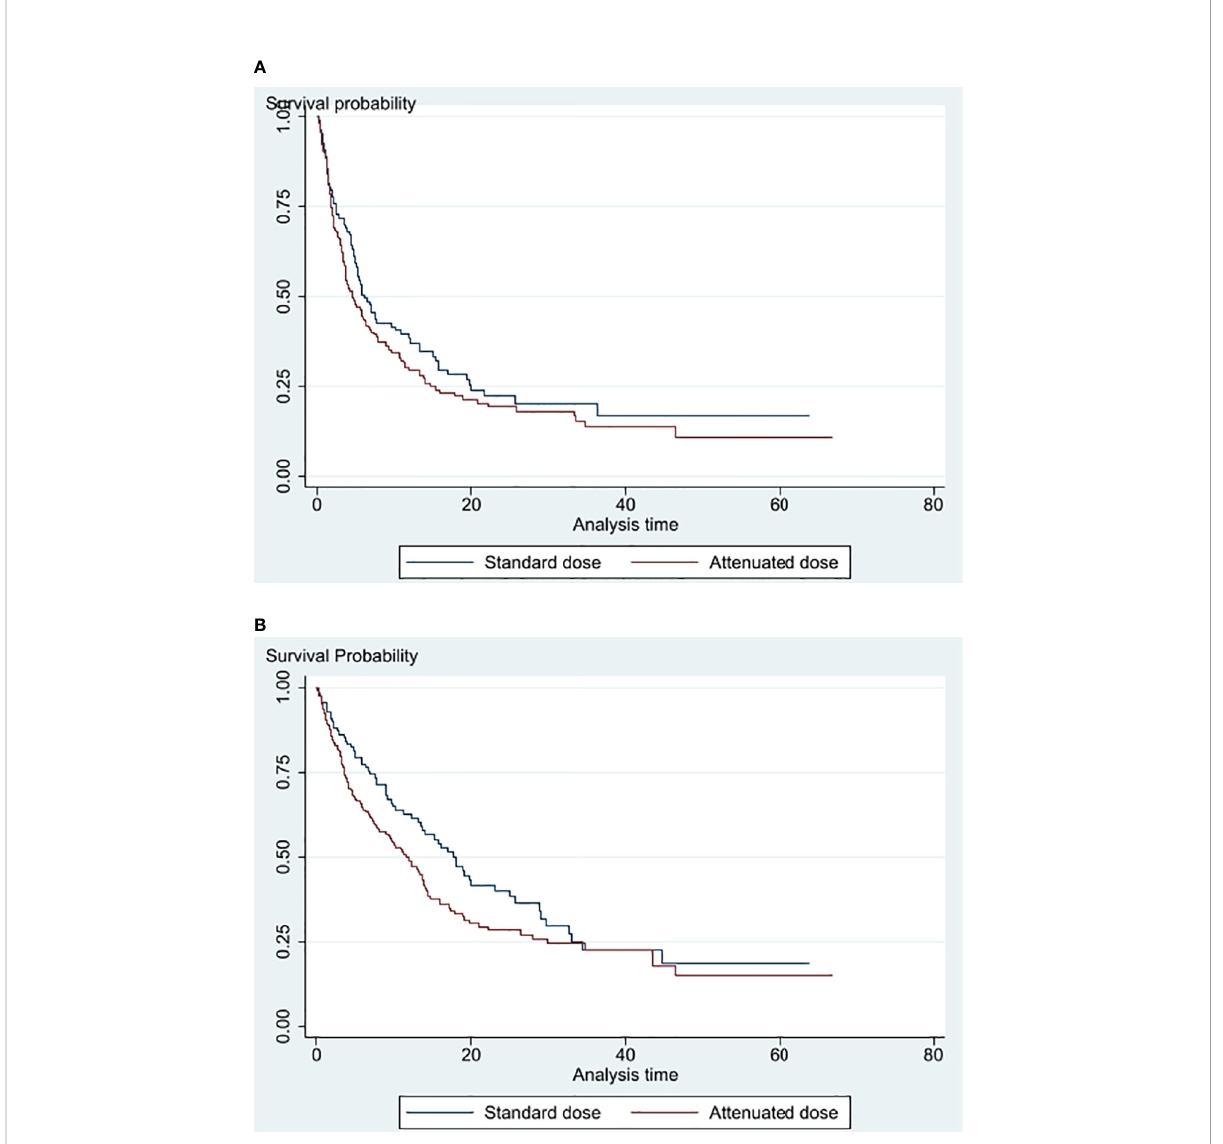
P Total Attenuated dose ICI Standard dose ( n = 165) ( n = 109)